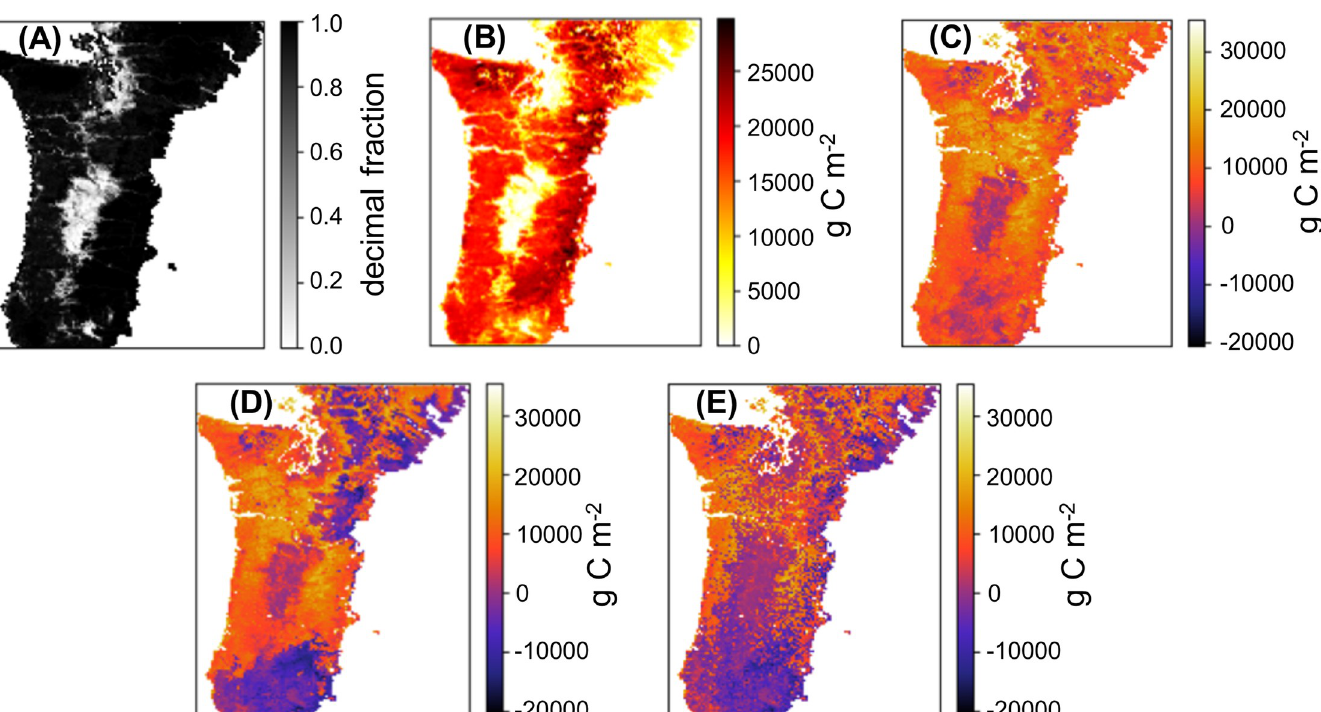
Fig 6. Human affected areas and carbon measures over the study area. (A) Density of NHA (non-human-affected) area used to calculate carbon densities. (B) AGT (aboveground total woody biomass) densities derived from [37] for 1991–1999. (C-E) Differences in carbon densities calculated by subtracting Hudiburg’s results from simulation results for 1991–1999: (C) NF-WCE (no fire, with CO 2 fertilization effect); (D) FF-WCE (full fire, with CO 2 fertilization effect) (E) SF-WCE (stochastic fire, with CO 2 fertilization